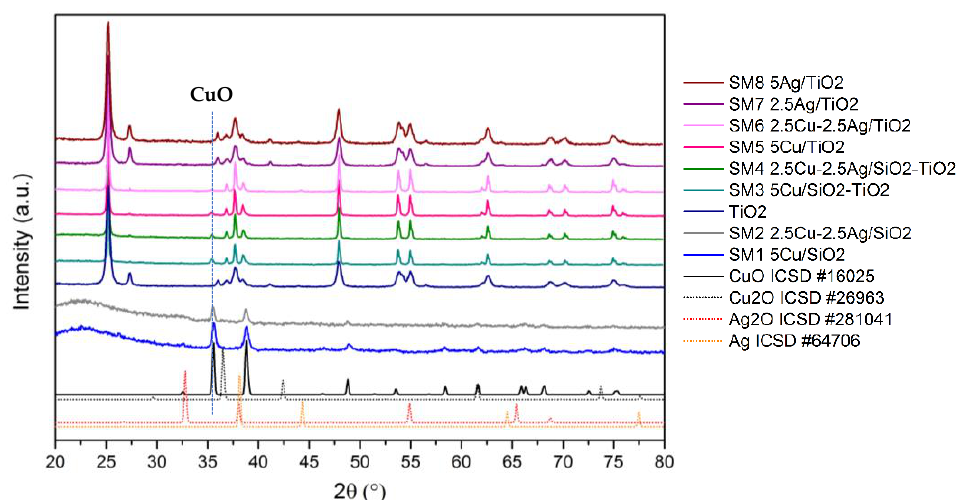
Figure 2. XRD patterns of reference and calcined materials.